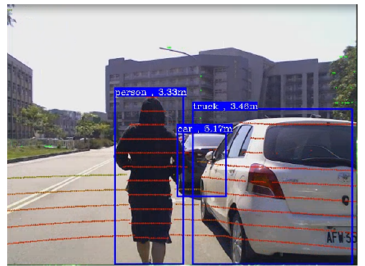
Figure 20. Road testing of people and vehicles.